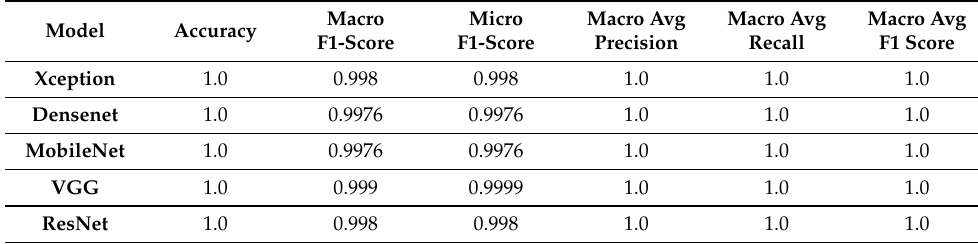
Figure 9. Accuracy curves for the feline reticulocyte dataset. ( a ) Xception. ( b ) DensNet. ( c ) MobileNet. ( d ) ResNet. ( e ) VGG. Table 5. Summary of results for traffic signs